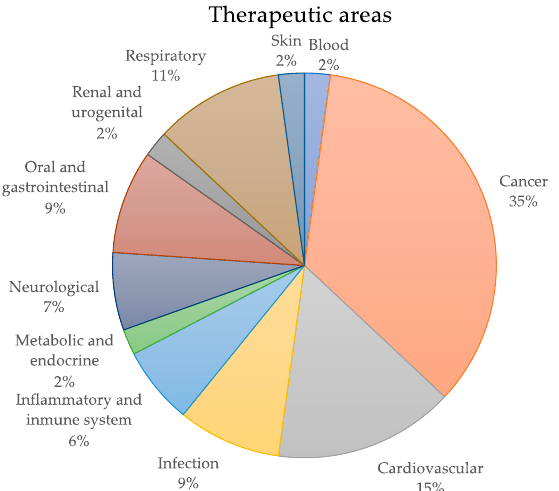
Figure 2. Pie chart displaying the classification of the NMR-based PMx studies based on the different health categories defined by the Health Research Classification System [106].